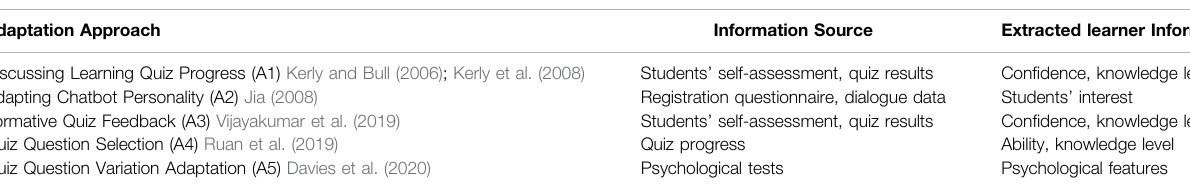
TABLE 2 | Adaptation approaches of chatbots in education. Adaptation